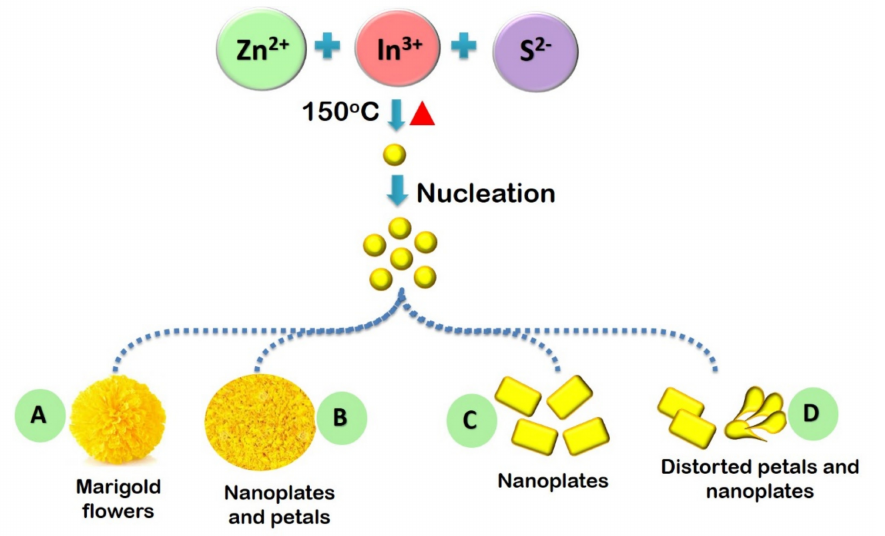
Figure 5. Schematic illustration of the growth of ZnIn 2 S 4 with different solvent concentrations. Figure adapted from